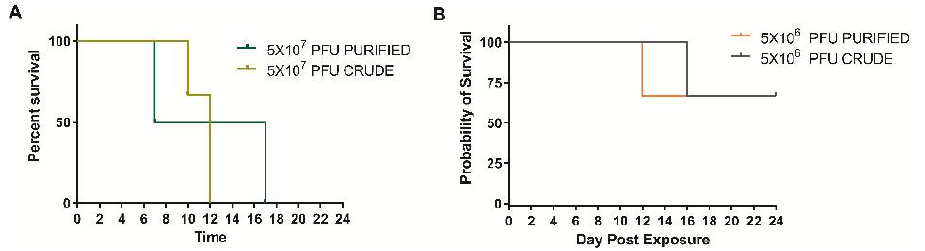
Figure 1. Percent survival in cynomolgus macaques intravenously exposed to either sucrose purified or traditional (crude) preparation at two concentrations of monkeypox virus. ( A ) The target dose for the high concentration was to mimic those used in viral therapeutic testing. ( B ) A 10-fold dilution of the high dose was utilized to determine any increased virulence (based on mortality) There were no significant differences (logrank test) in survival curves in either the high or low dose groups ( p = 0.3213 and 0.8864, respectively).